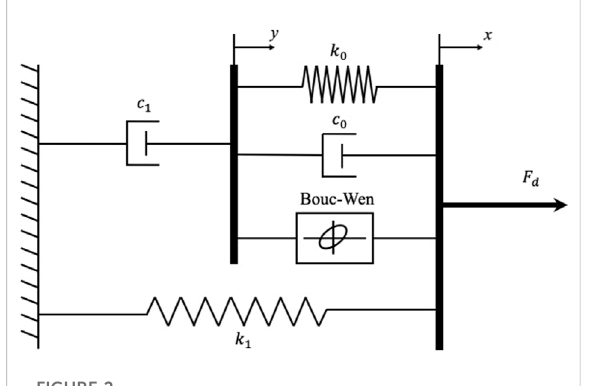
FIGURE 2 Modi fi ed Bouc-Wen model for MR damper, (Spencer et al.,